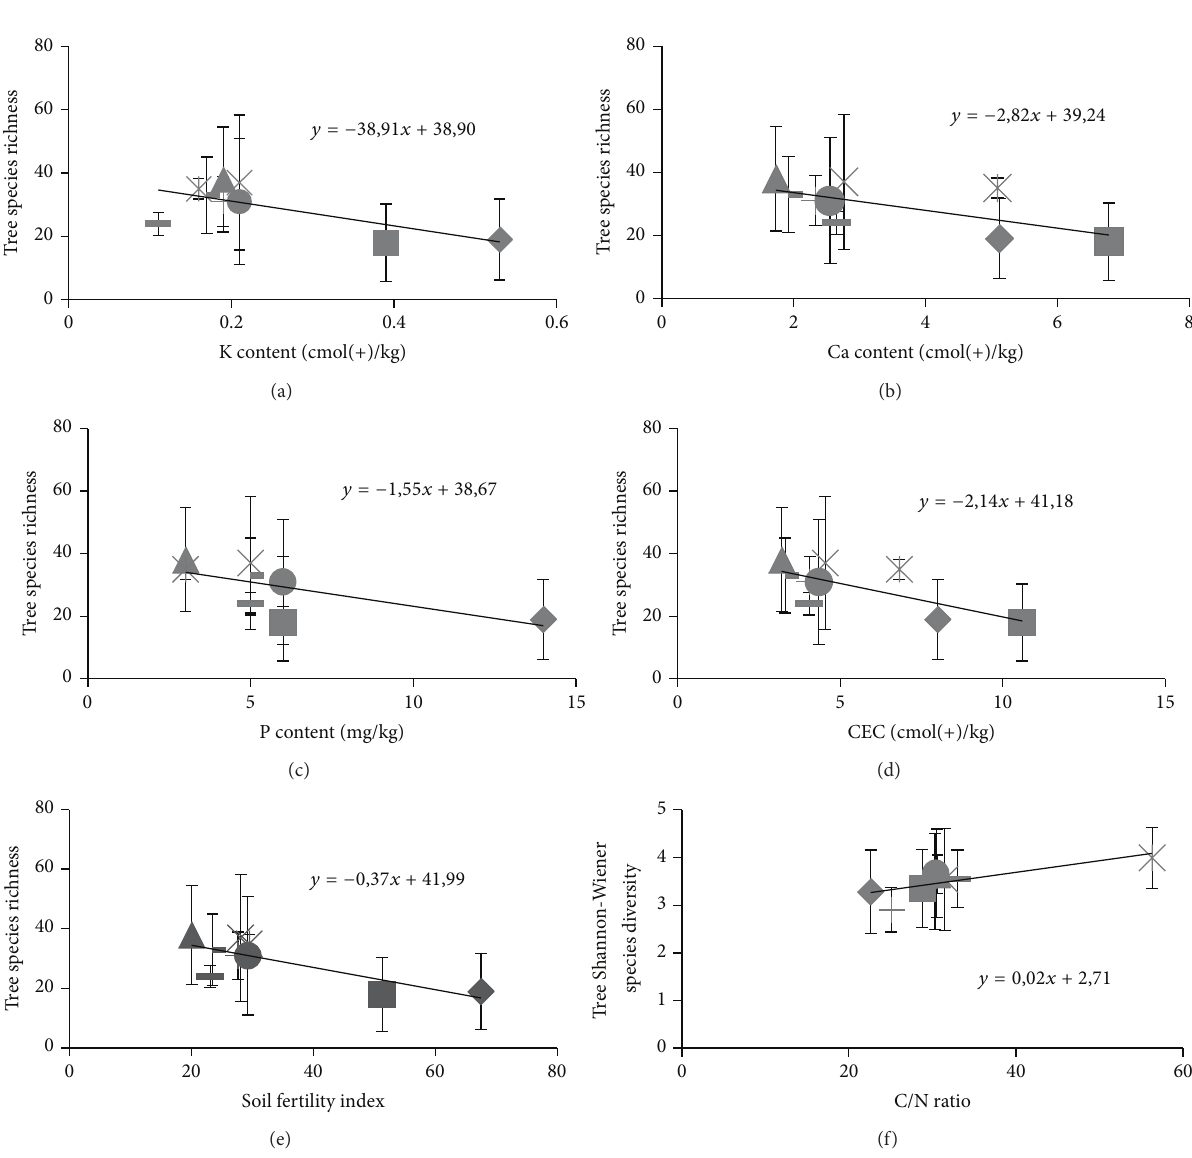
Figure 3: Linear regression relationships between tree species richness and the following soil chemical factors: (a) K content (cmol(+)/kg), (b) Ca content (cmol(+)/kg), (c) P content (mg/kg), (d) cation exchange capacity, and (e) soil fertility index and Shannon-Wiener tree species diversity and (f) C/N ratio (means ± 95%